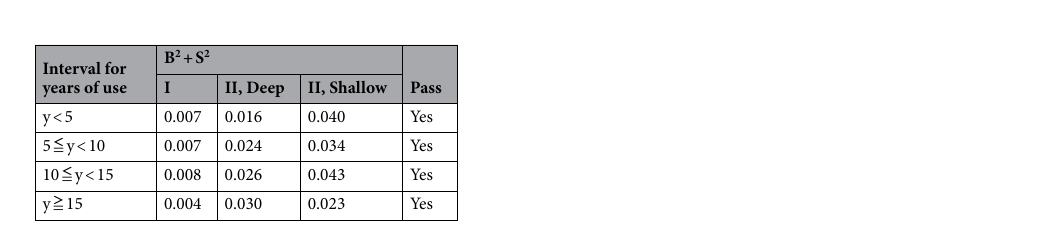
Table 3. The blind test result corresponded to each interval for years of use in this study.